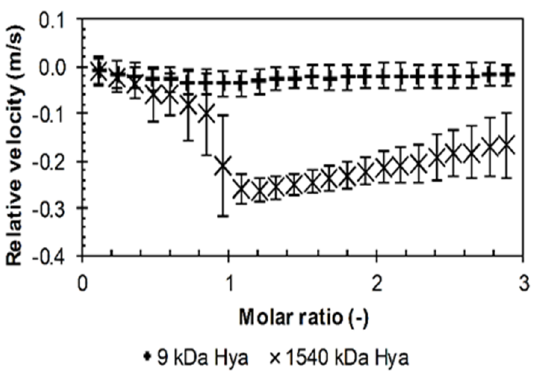
Figure 1. The relative ultrasonic velocity in dependence on molar ratio for titrations of arginine octamer in hydrochloride form to hyaluronan of different molecular weights in water (11.6 MHz, 25 °C).